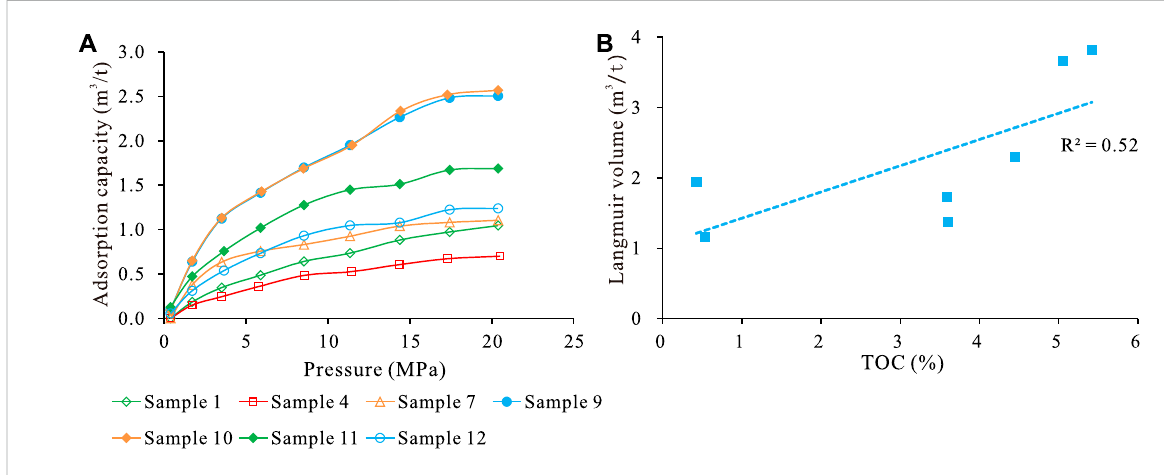
FIGURE 8 (A) Isothermal adsorption curves of shale samples and (B) relationships between the TOC and V L of shale